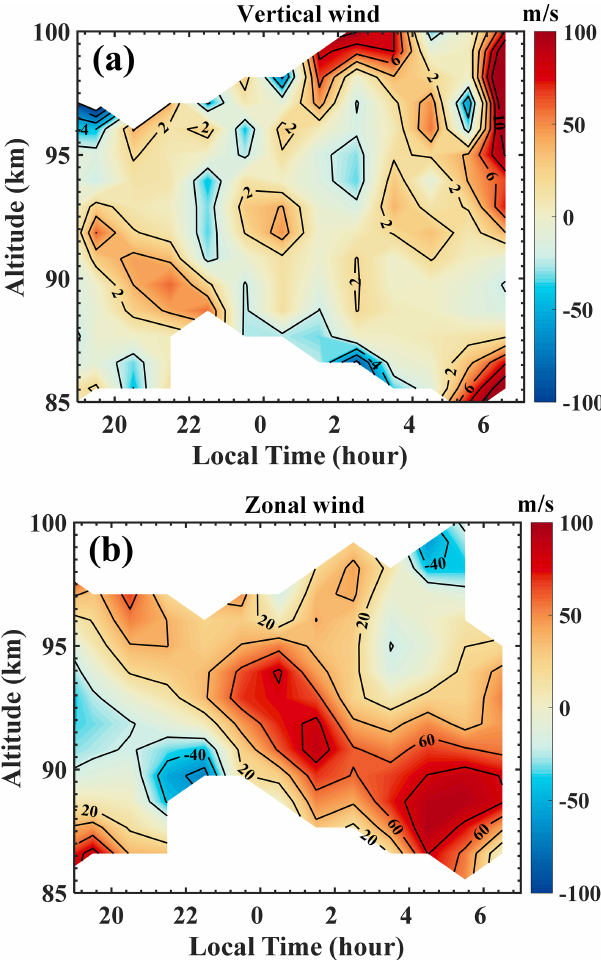
Figure 9. Zonal wind contour of (a) PMCW-NSL with a vertical resolution of 1km and temporal resolution of 1h and (b) meteor radar with a vertical resolution of 2km and a temporal resolution of 1h on 1 December